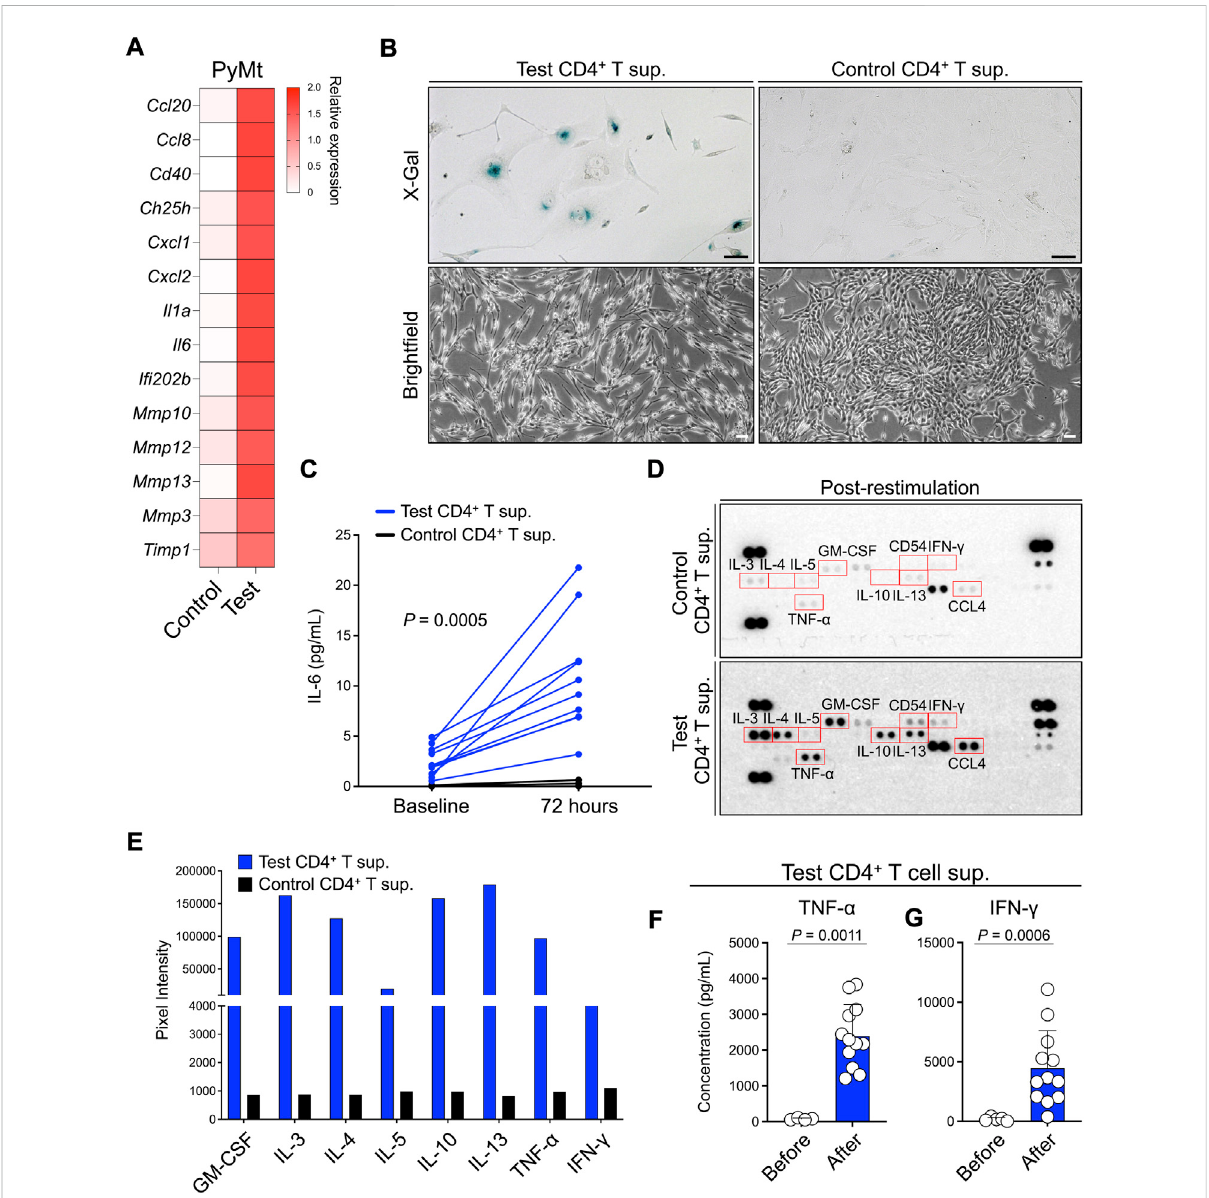
FIGURE 3 TSLP-activated CD4 + T cell supernatant induces senescence-like phenotype in PyMt cells. (A) The transcriptome analysis for SASP gene expressioninPyMtcellstreatedwithTSLP-activatedWTCD4 + Tcellsupernatant(sup.)(test, n =6)versusTslpr KO CD4 + Tsupernatant(control, n =4). The heatmap demonstrates the ratio between mean fragments per kilobase of transcript per million mapped reads (FPKM) value of each group and theaverageofmeanFPKMvalues ofthetwogroups. (B) RepresentativeimagesofX-Galstaining(upperpanels)andbright fi eld(lowerpanels)of PyMt cells treated with test versus control CD4 + T supernatant (scale bars: 100 μ m). The beta-galactosidase activity was detectable at pH 6.0. (C) Quanti fi cationofIL-6concentration, measuredbyELISA, intest( n =10)versuscontrolCD4 + Tcellsupernatants( n =8)beforeand72 hafterinPyMt cellculture( p =0.0005,two-wayANOVA). (D) RepresentativemagesofproteinarraysperformedonCD4 + Tcellssupernatantsfromthecontrol(top panel) and test T cells (bottom panel). Supernatants used in this assay were collected after CD4 + T cell stimulation in vitro . Red boxes highlight upregulated cytokines in test compared with control CD4 + T cells supernatant, including Th1-associated cytokines (TNF- α and IFN- γ ) and Th2- associated cytokines (IL-3, IL-4, IL-5, IL-13, GM-CSF). (E) Quanti fi cation of cytokines upregulated in test CD4 + T cell supernatant on protein arrays using ImageJ. (F,G) Quanti fi cation of (F) TNF- α and (G) IFN- γ concentrations, measured by ELISA, in testCD4 + T cell supernatants before ( n = 4) and after restimulation ( n = 12), Mann-Whitney U test. Post-restimulation supernatants were collected after three cycles of stimulation with anti-CD3/ CD28 antibodies plus TSLP. Bar graphs show mean + s.d. The same amount of total protein for each sample was used for protein detection and quanti fi cation in (D – G) .